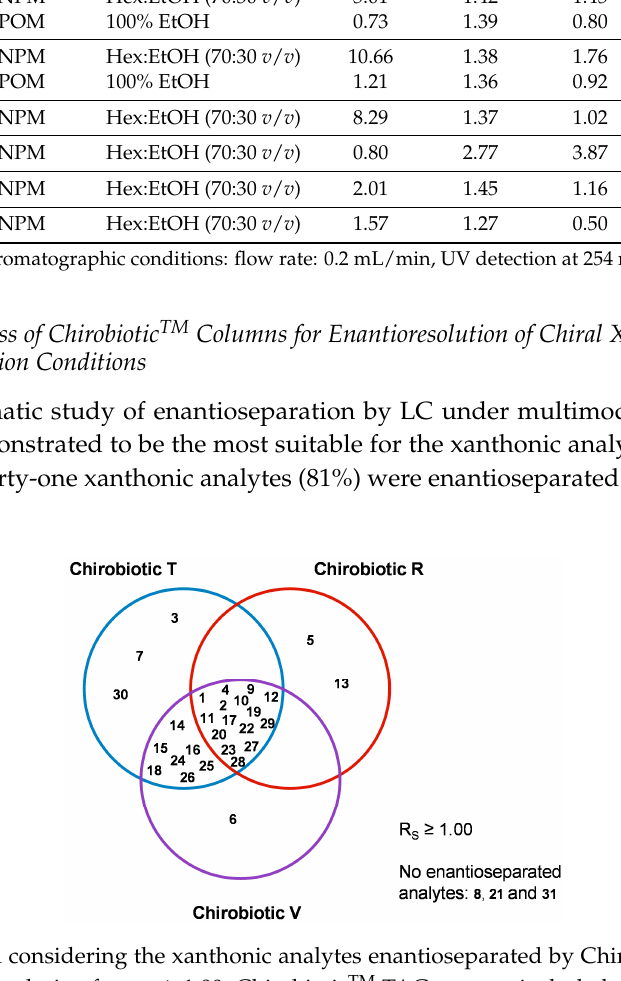
Table 4. Chromatographic data, retention factor of first eluted enantiomer ( k 1 ), separation factor ( α ), resolution ( R S ), and elution order, for the chiral xanthonic analytes on the Chirobiotic TM TAG column, under multimodal chromatographic conditions.